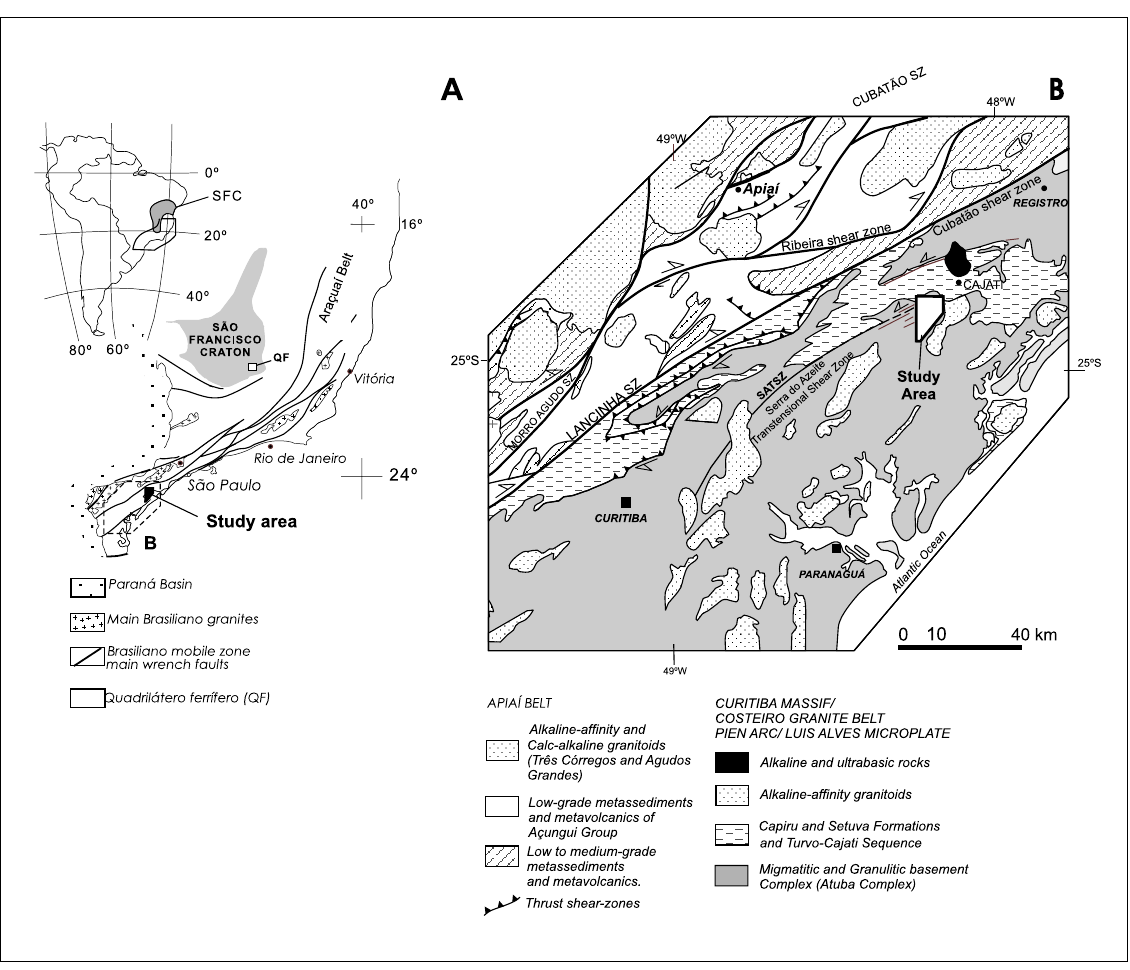
Fig. 1 – (A) Tectonic sketch of the Ribeira and Araçuaí belts, southern Brazil; (B) Geological-structural map of the northern portion of the Costeiro Granite belt, and localization of the study area (modified from Machado et al. 2001, Dehler et al. 2000, Basei et al.